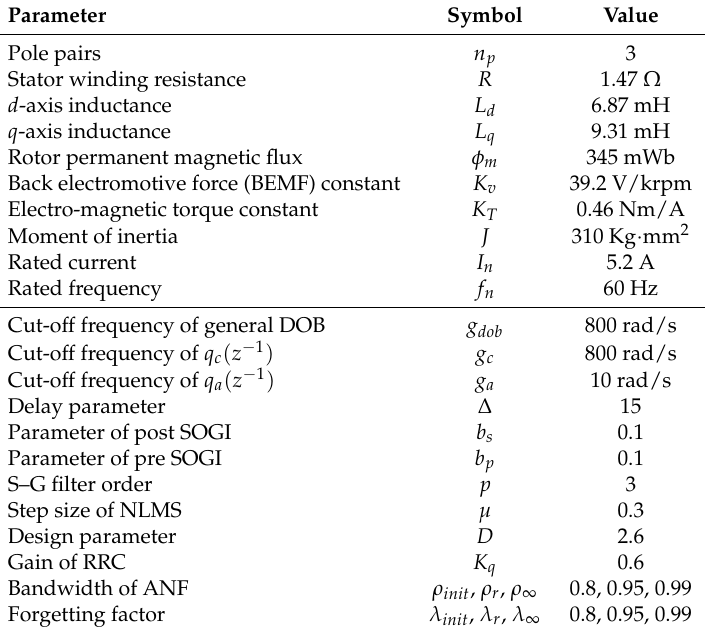
Table 3. Experimental